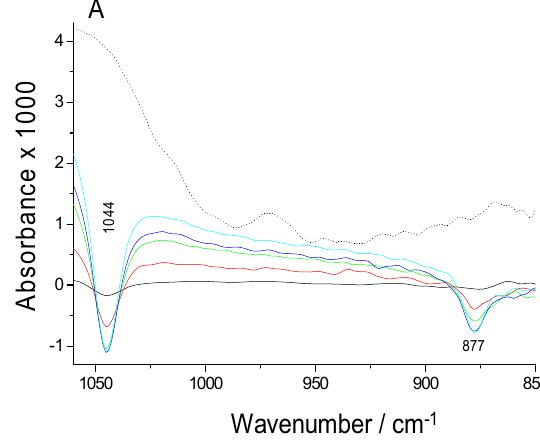
Figure 3. Enzymatic reaction of ADH. (A) Series of overlaid spectra (solid line) of infrared absorbance changes upon ethanol addition to ADH, recorded for 30 minutes. The spectra in solid line were recorded at 12 s (black), 4 min (red), 8 min (green), 16 min (blue) and 30 min (cyan). The dotted line is the last spectrum (30 min) of the control experiments without substrate. (B) Kinetics of the enzymatic reaction of ADH monitored by the integrated band intensity at 877 cm -1 for reaction (black) and the control (red)